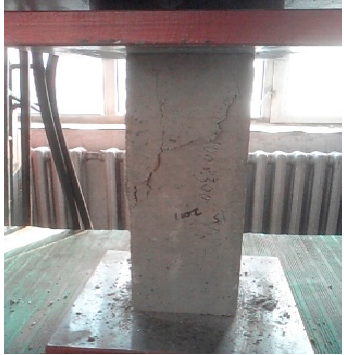
Figure 7. Cube for material test. Table 2. Mechanical properties of husk mortar